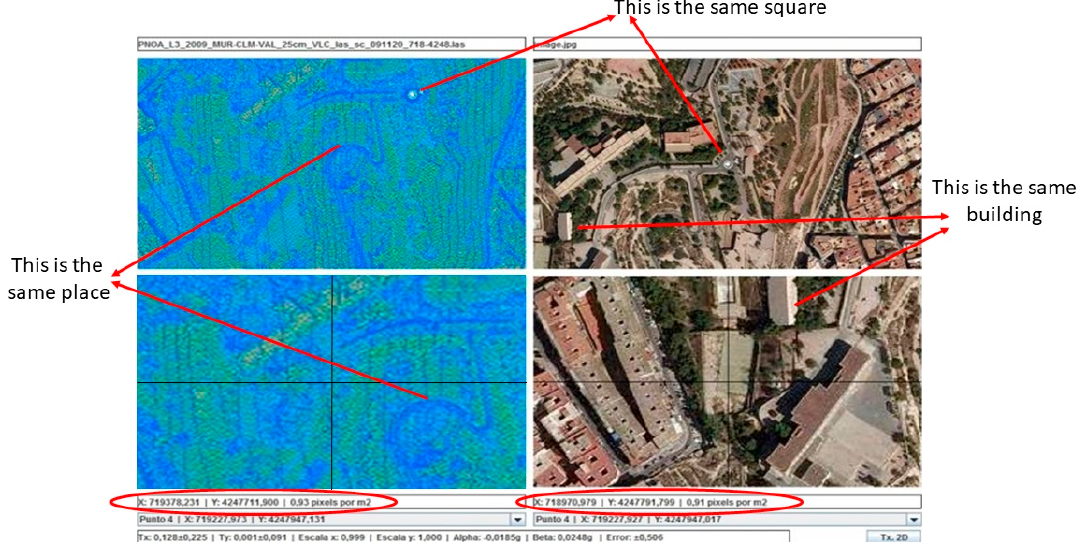
Figure 8. Screenshot of the planimetric control with the mean squared error obtained. The software allows you to move the images independently. See the coordinates of two images at the button in the first box. The cross is only used to target a